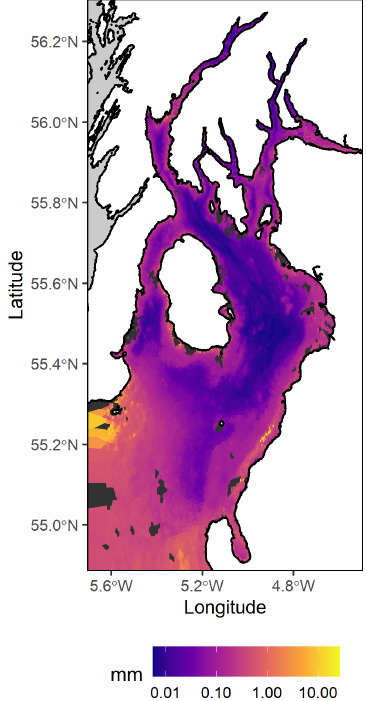
Figure 10. Mapped predictions of median grain size for seabed sed- iments in the Firth of Clyde.